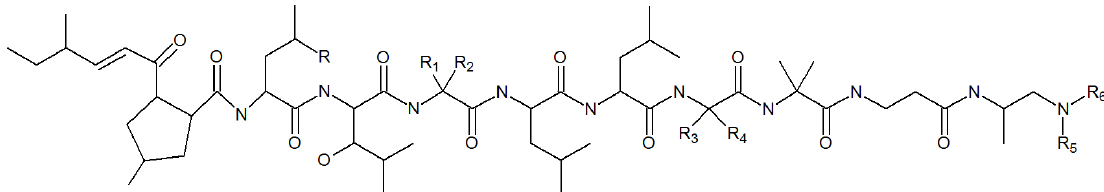
Figure 1. The structures of leucinostatins.